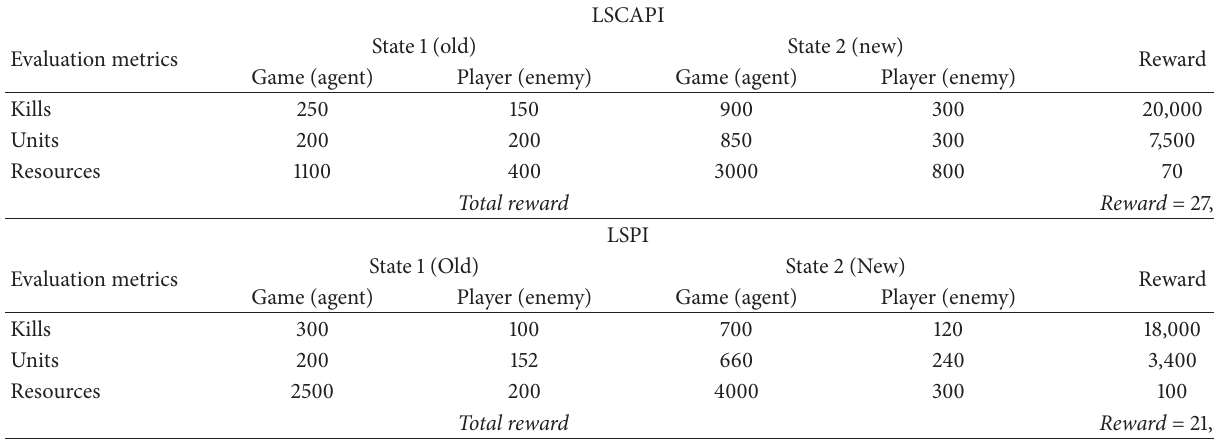
Table 6: Three towers case.